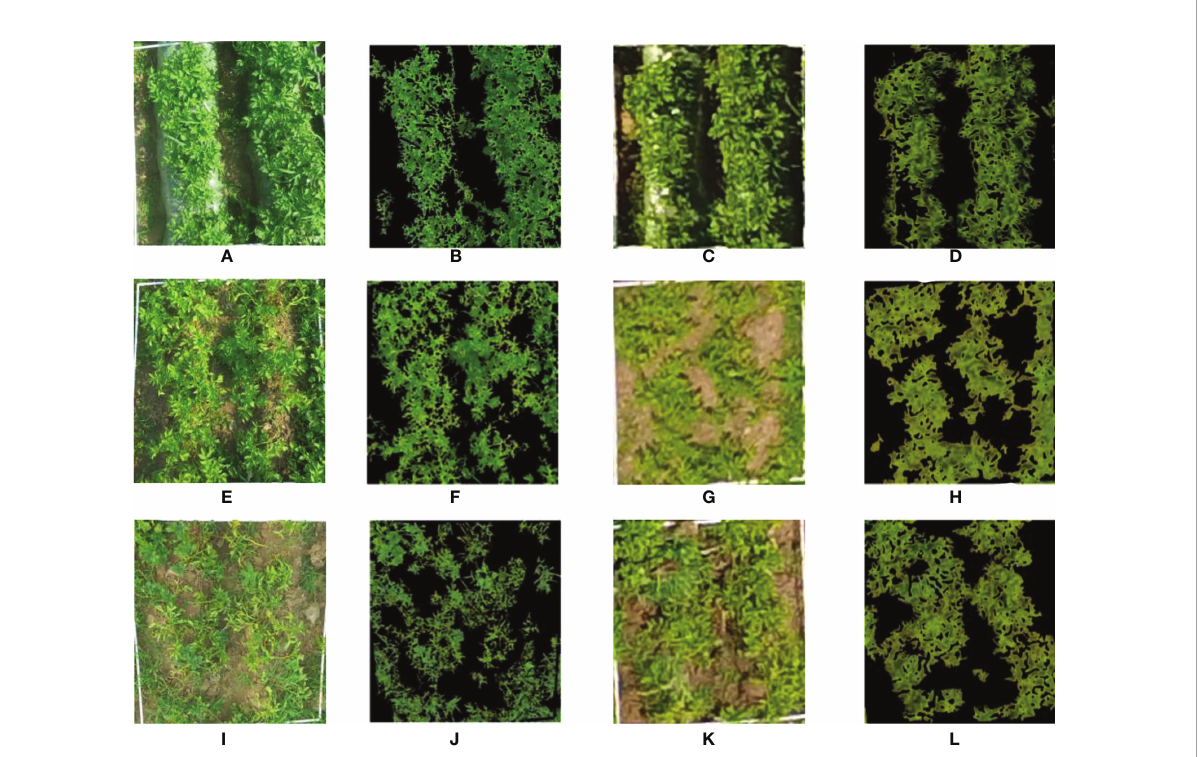
FIGURE 4 Comparison of two methods for extracting potato coverage. (A, E, I) Ground digital photos of the potato plants at S1-S3; (B, F, J) The effect of potato CC extraction using ground digital photo at S1-S3; (C, G, K) UAV digital images of potato plants at S1-S3; (D, H, L) The effect of potato CC extraction using UAV digital image at